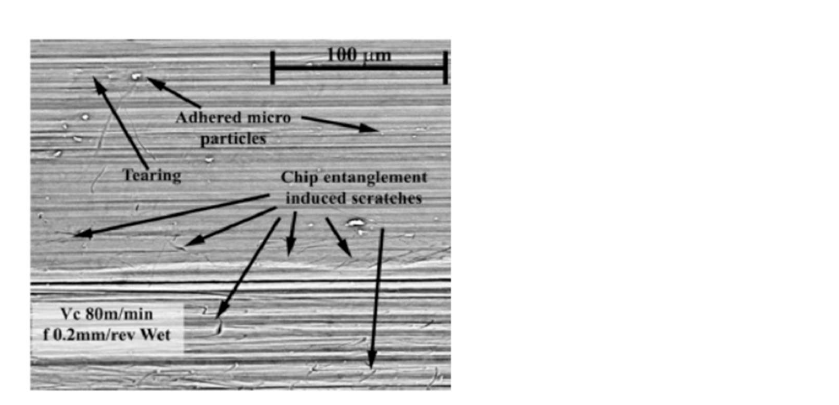
Figure 5. Scratches and adhered particles provoked by chip entanglements after 8 min of wet cutting [107] (Reprinted with permission from [107]. Copyright 2017, Elsevier). Sartori et al. [109] studied the machining of DMLS-produced Ti-6Al-4V by using cryogenic cooling during the turning process to improve surface integrity (Figure 6).